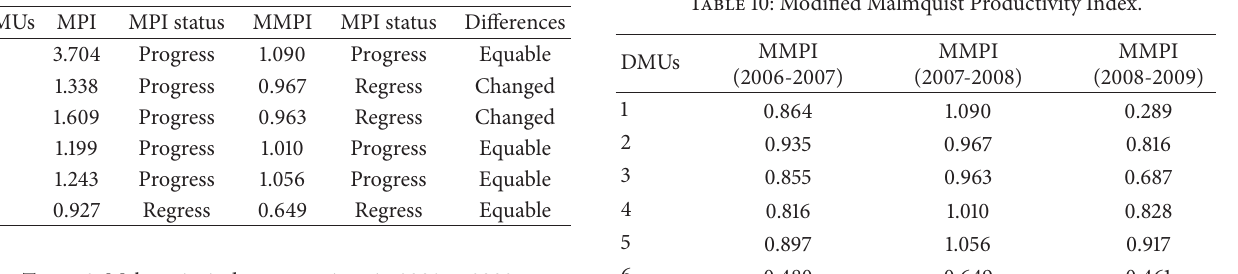
Table 8: Malmquist index comparison in 2009 to 2008.